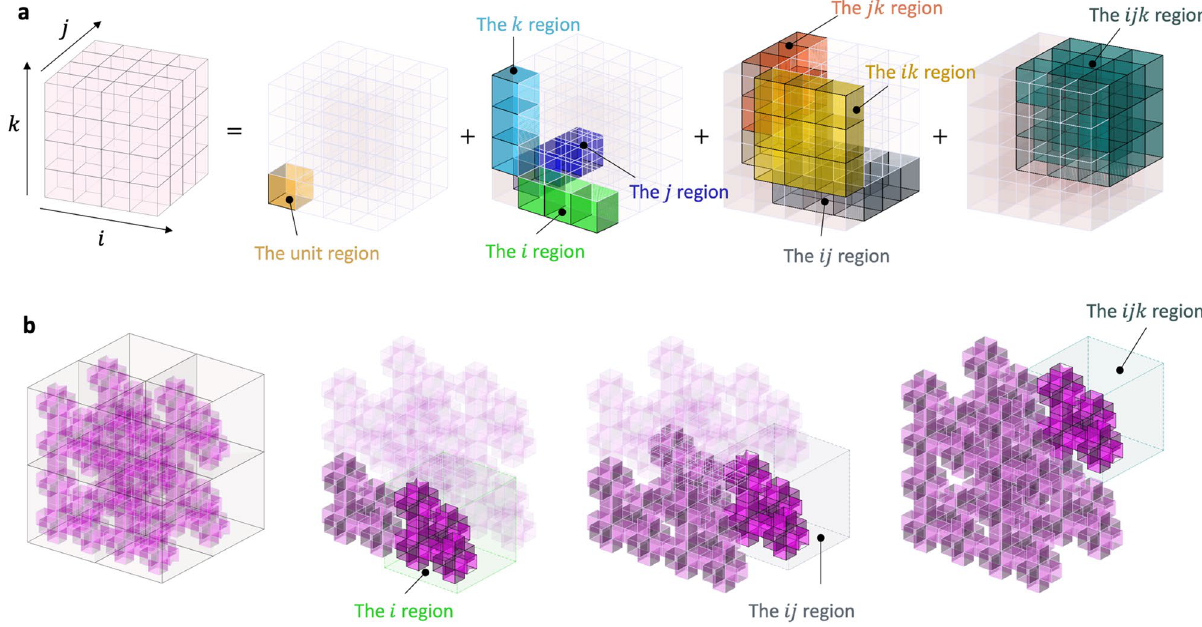
Figure 7. Analytical procedure to obtain mobility of network structures; ( a ) divided regions in a 3D space ( b ) an example of network structure with an extended unit cell (n = 4, c =